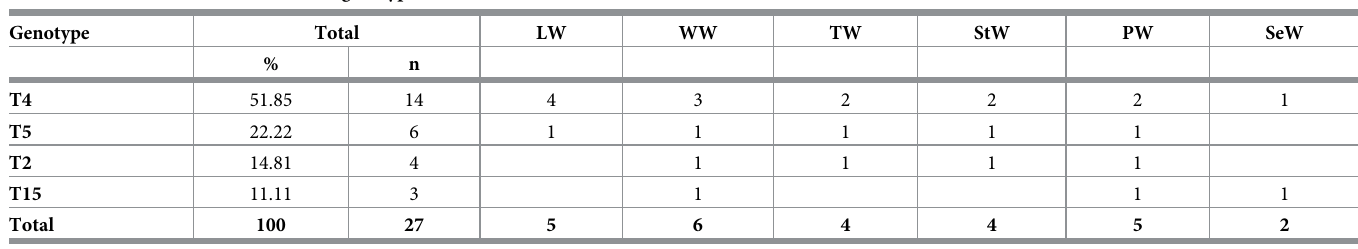
Table 4. Distribution of Acanthamoeba genotype in various water sources.